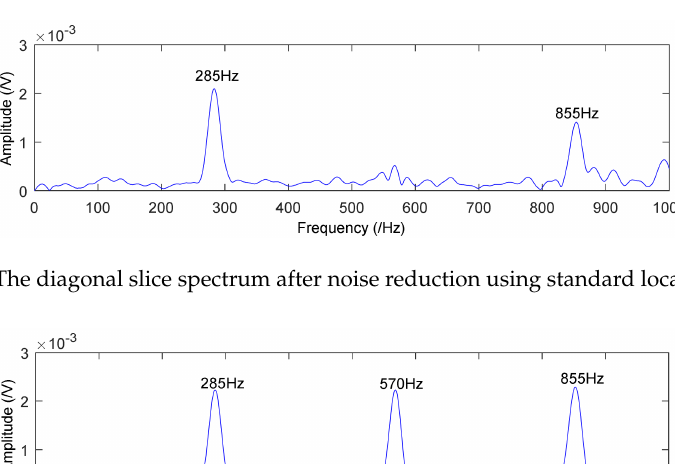
Figure 32. The frequency spectrum after noise reduction using smooth orthogonal decomposition.